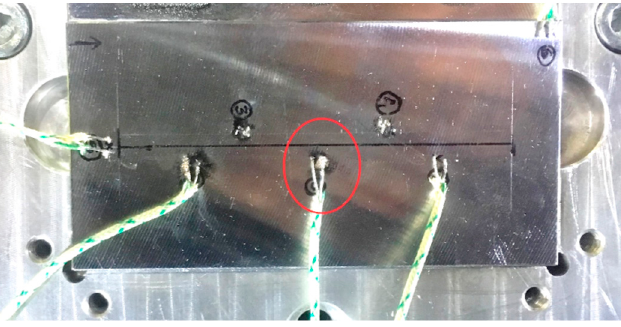
Figure 3. Thermocouples welded on the base plate.